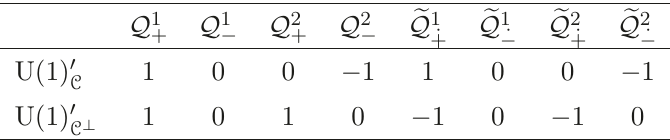
Table 3 . Holomorphic-topological twist.